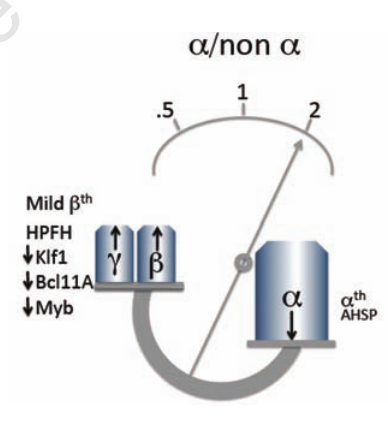
Figure 1. Genetic modifying factors in β - thalassemia. Modifying factors generally act by reducing or increasing the altered globin biosynthetic ratio typical of tha- lassemia.